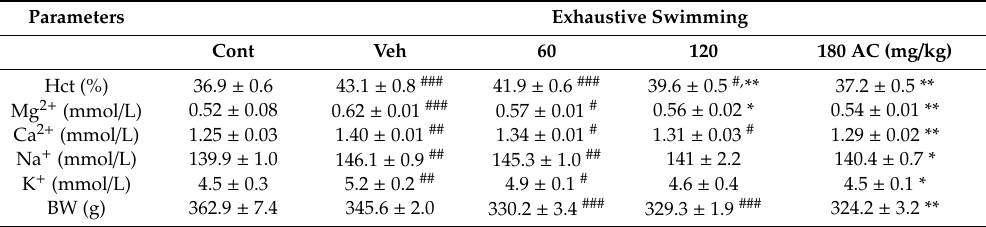
Table 1. Aralia continentalis kitagawa (AC) extract preserved changes in hemodynamic parameter and blood ions after exhaustive